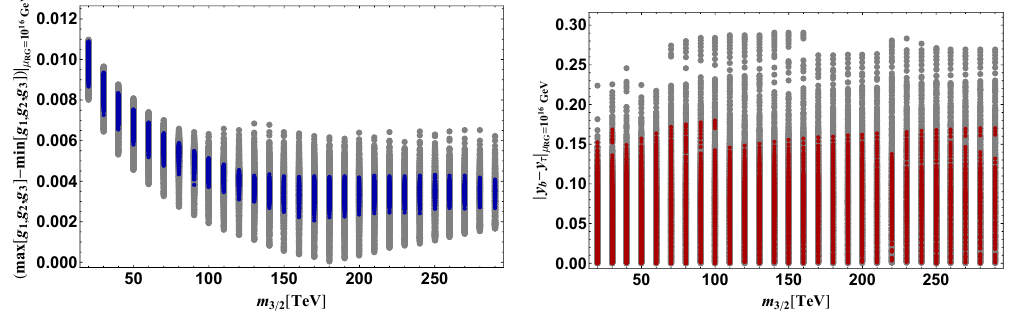
Figure 6 . Precisions of gauge and Yukawa coupling uni(cid:12)cations in the left and right panel, respec- tively. The gray points satisfy (4.1). On blue/red points, the neutralino is LSP. The ranges of the parameters are same as in (cid:12)gure